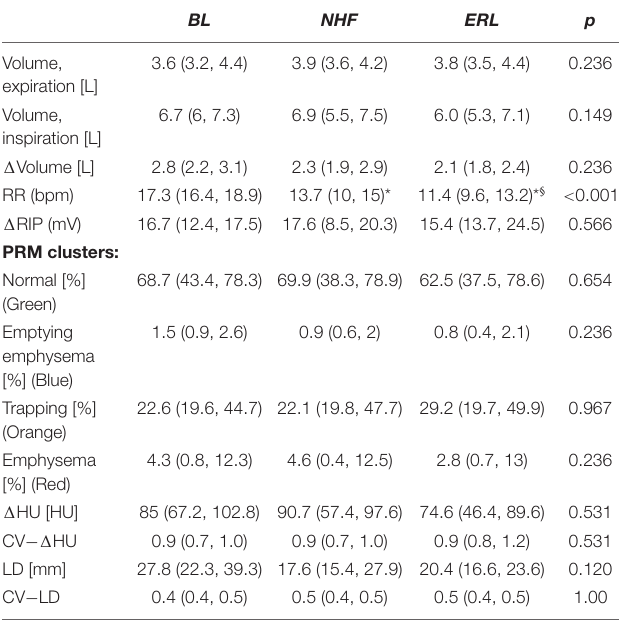
TABLE 2 | CT registration-based regional lung function data.